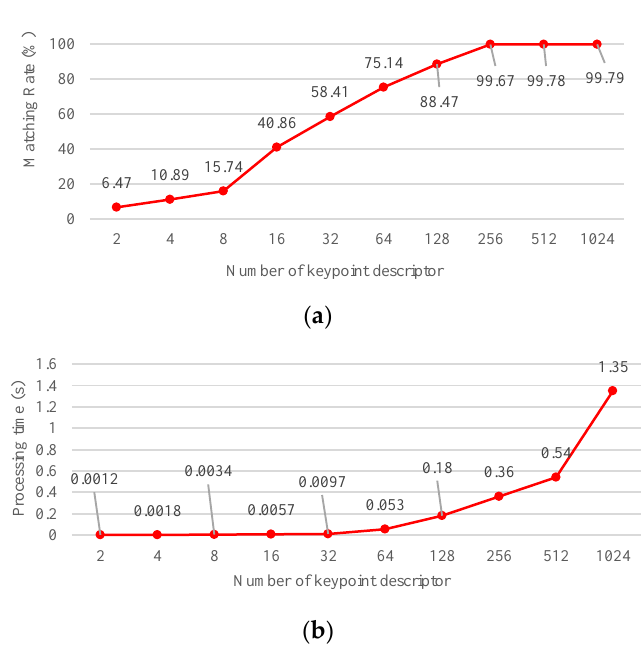
Figure 9. Performance comparison between ( a ) matching rate and ( b ) processing time with various numbers of keypoint descriptors.